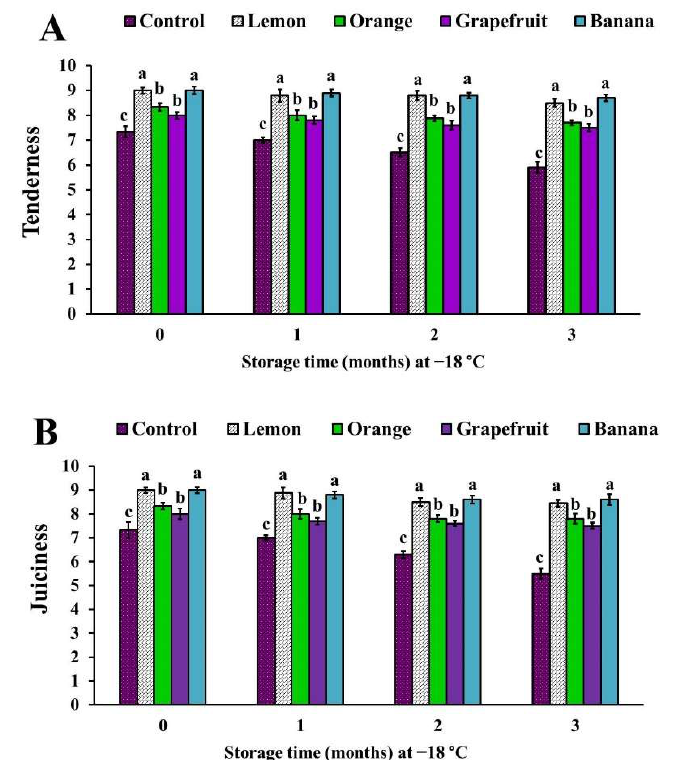
Figure 3. Tenderness ( A ) and juiciness ( B ) scores of chicken patties treated with different fruit peel powders. Columns marked by different letters indicate significant differences ( p < 0.05).